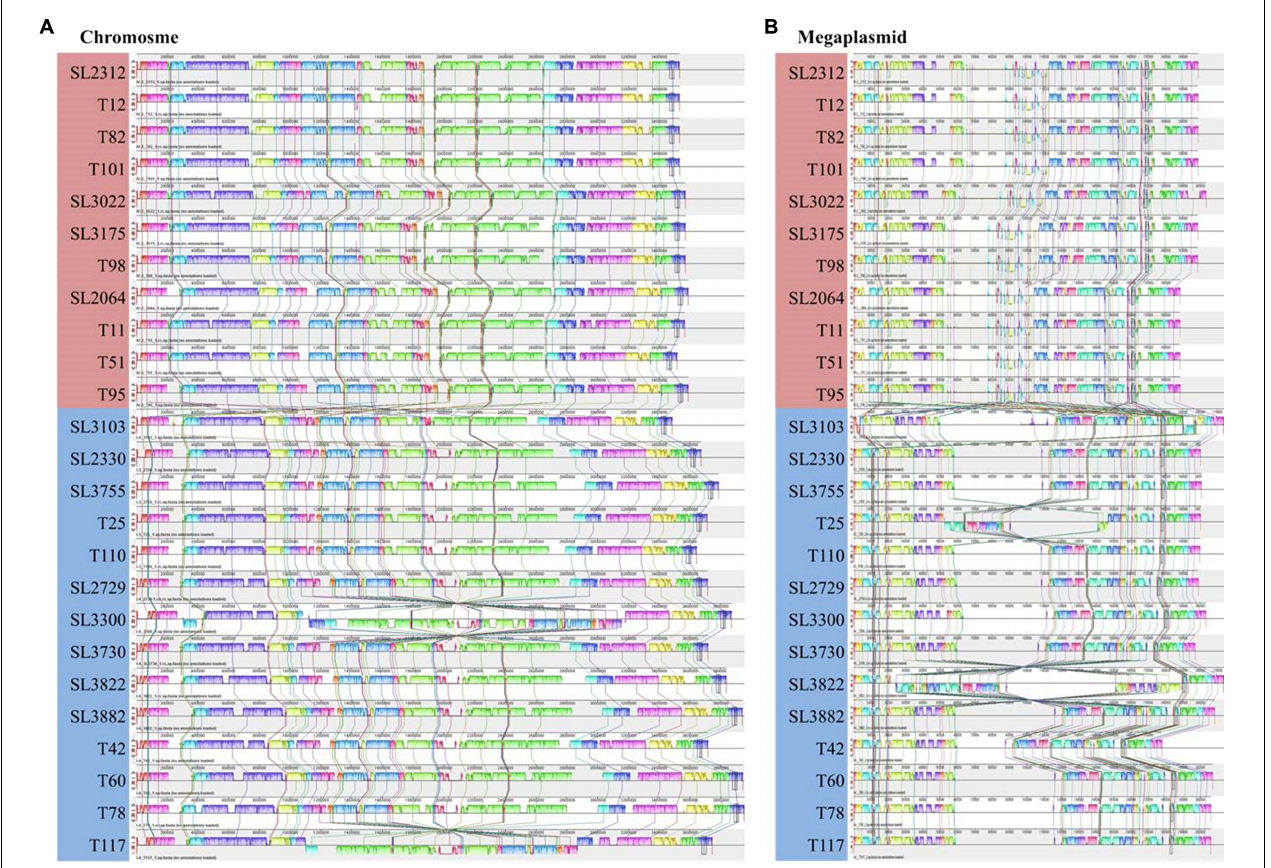
FIGURE 2 | Multiple genome alignment for 25 Korean RSSC strains produce using Mauve software. The sequences of chromosome (A) and megaplasmid (B) were aligned. The red and blue boxes represent phylotype IV and I, respectively. Colored lines between genomes represent rearrangements or